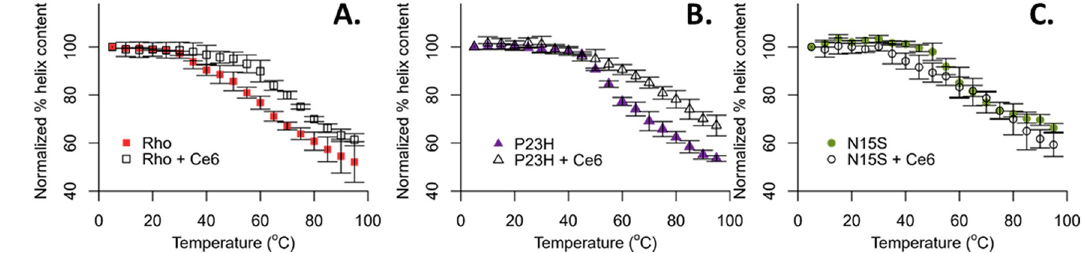
Fig 5. Circular dichroism spectroscopy of WT and mutant rhodopsin in the presence and absence of chlorin e6. Thermal denaturation studies of rhodopsin in the presence and absence of chlorin e6 (Ce6) were evaluated using circular dichroism (CD). A. CD melting spectra of WT rhodopsin (2.5 μ M) with and without 100 μ M Ce6. B. CD melting spectra of P23H. C. CD melting spectra of N15S. Concentrations of protein and chlorin e6 in B and C were the same as in